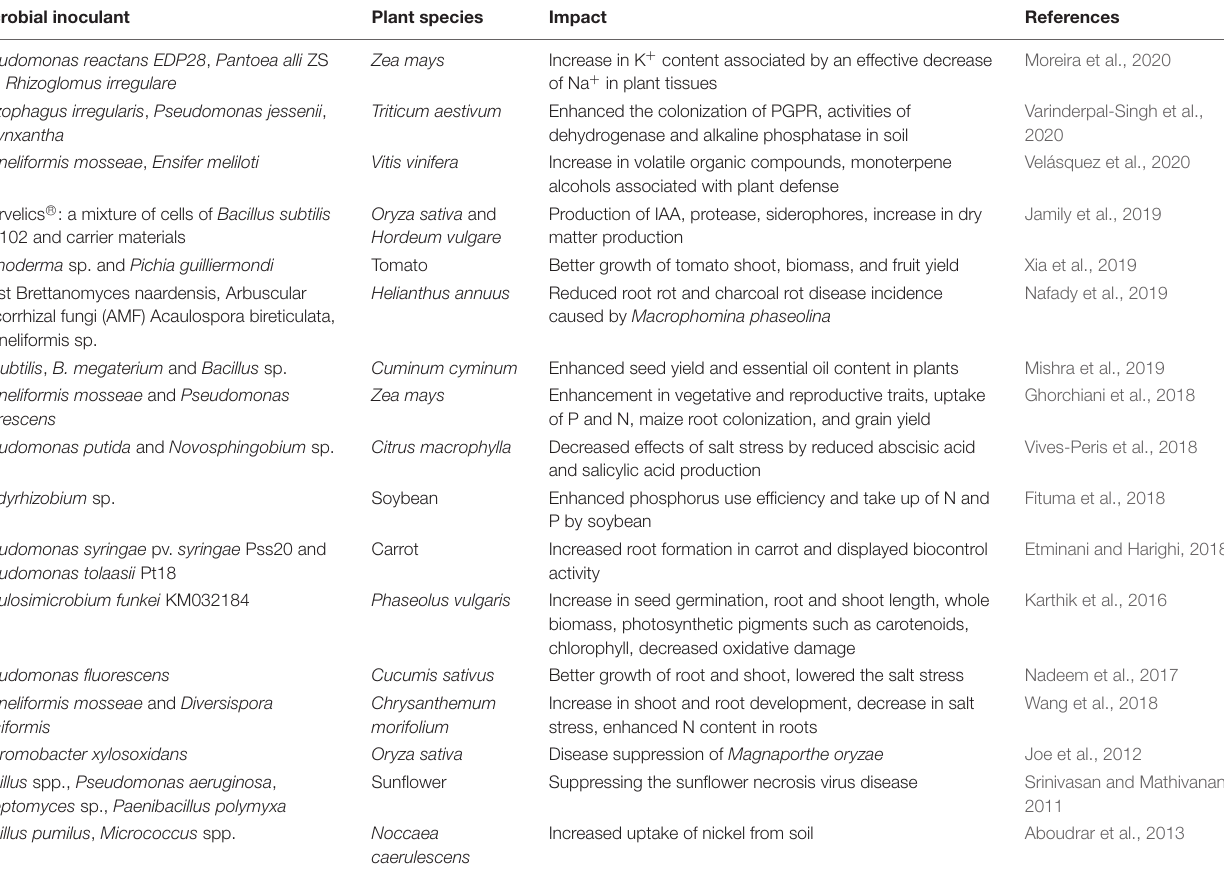
TABLE 1 | Various microbial inoculants in consortia or single application and their effect on plants for growth promotion and